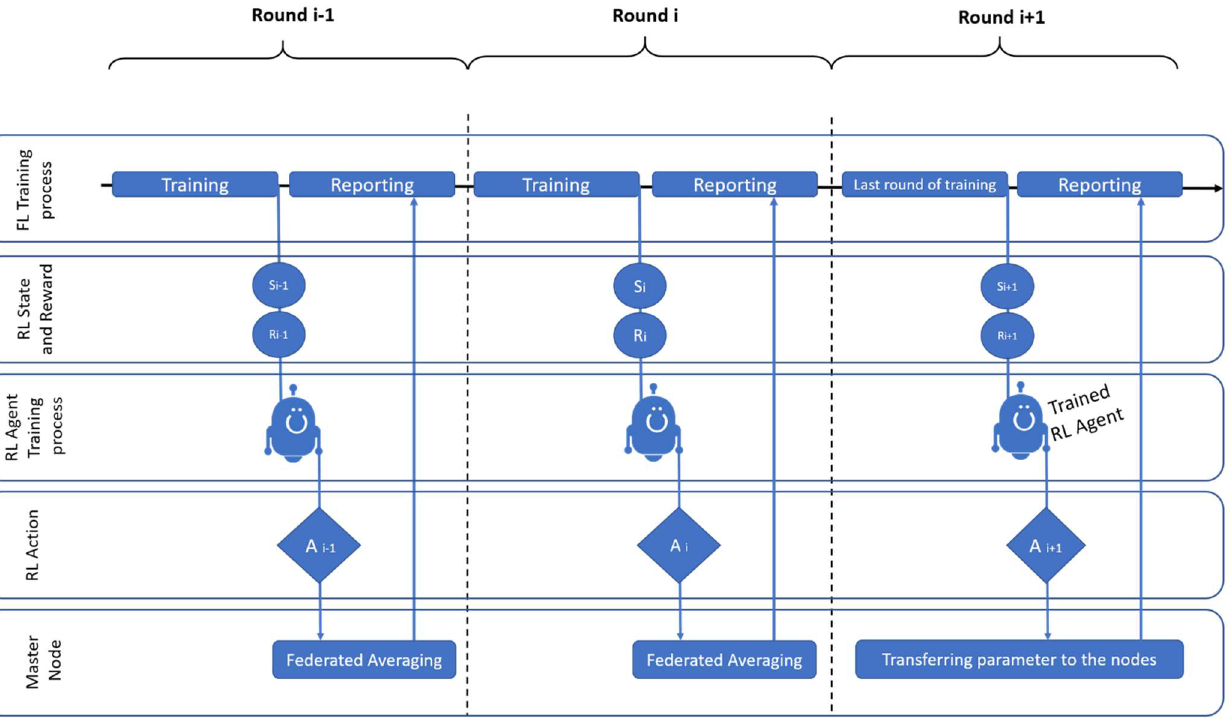
Figure 4. Training of the RL agent.